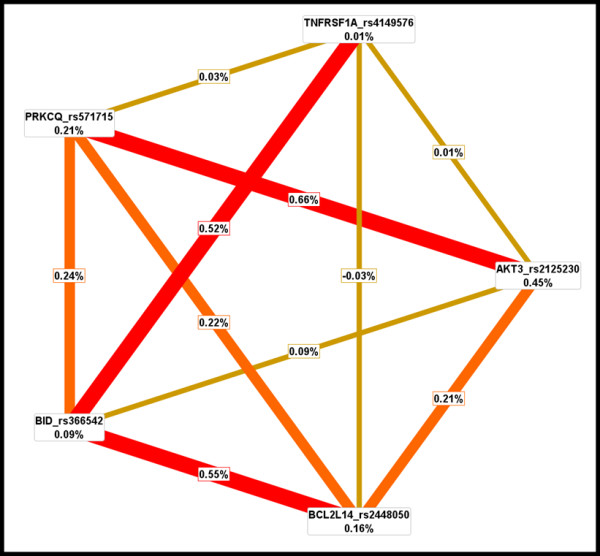
Interaction Entropy model. This graphical model, describes the percent entropy that is explained by each apoptosis-related SNP or pairwise combination within our study population. Positive percent entropy indicates information gain (IG) or synergy; whereas, negative percent indicates redundancy or lack of information gain (IG). Schematic coloration used in the visualization tools represents a continuum from synergy (i.e. non-additive) to redundancy. The colors range from red representing a high degree of synergy (positive information gain (IG)), orange a lesser degree, and gold representing independence and a midway point between synergy and redundancy. On the other hand, green and blue represent redundancy, which is not apparent in the current analysis.